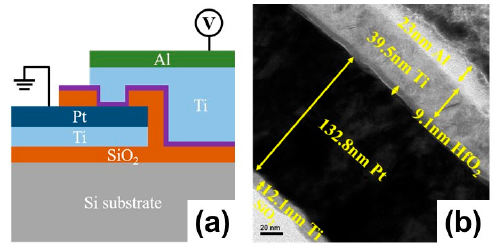
Figure 1. ( a ) Schematic diagram of the RRAM device with Al/Ti/HfO 2 /Pt/Ti and a ( b ) cross-section image of the TEM. image of the